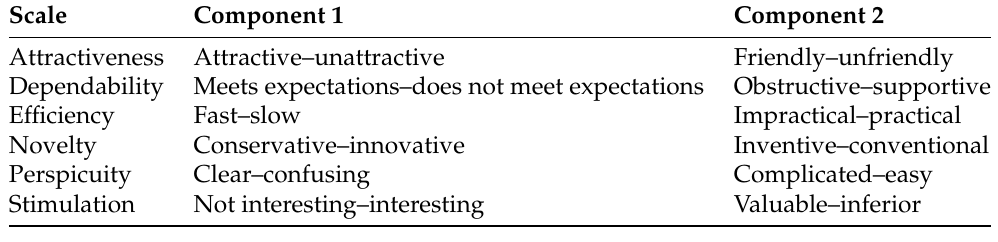
Table 5. UEQ scales used in the app evaluation and their individual components.